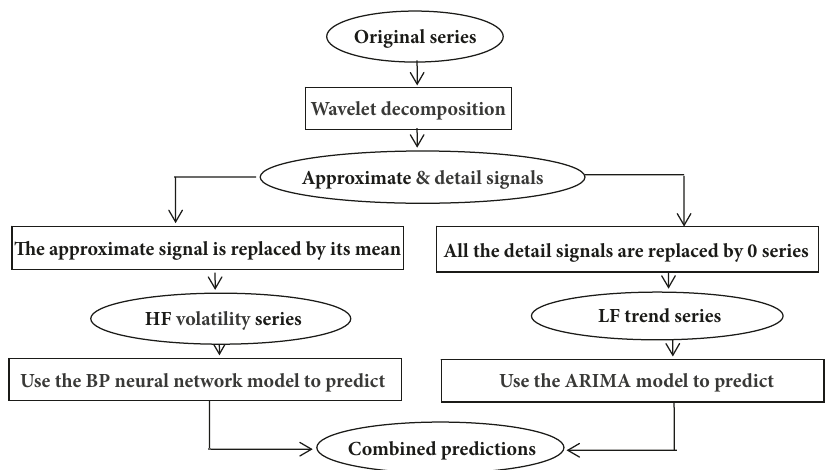
Figure 1: Topological graph of combination forecasting